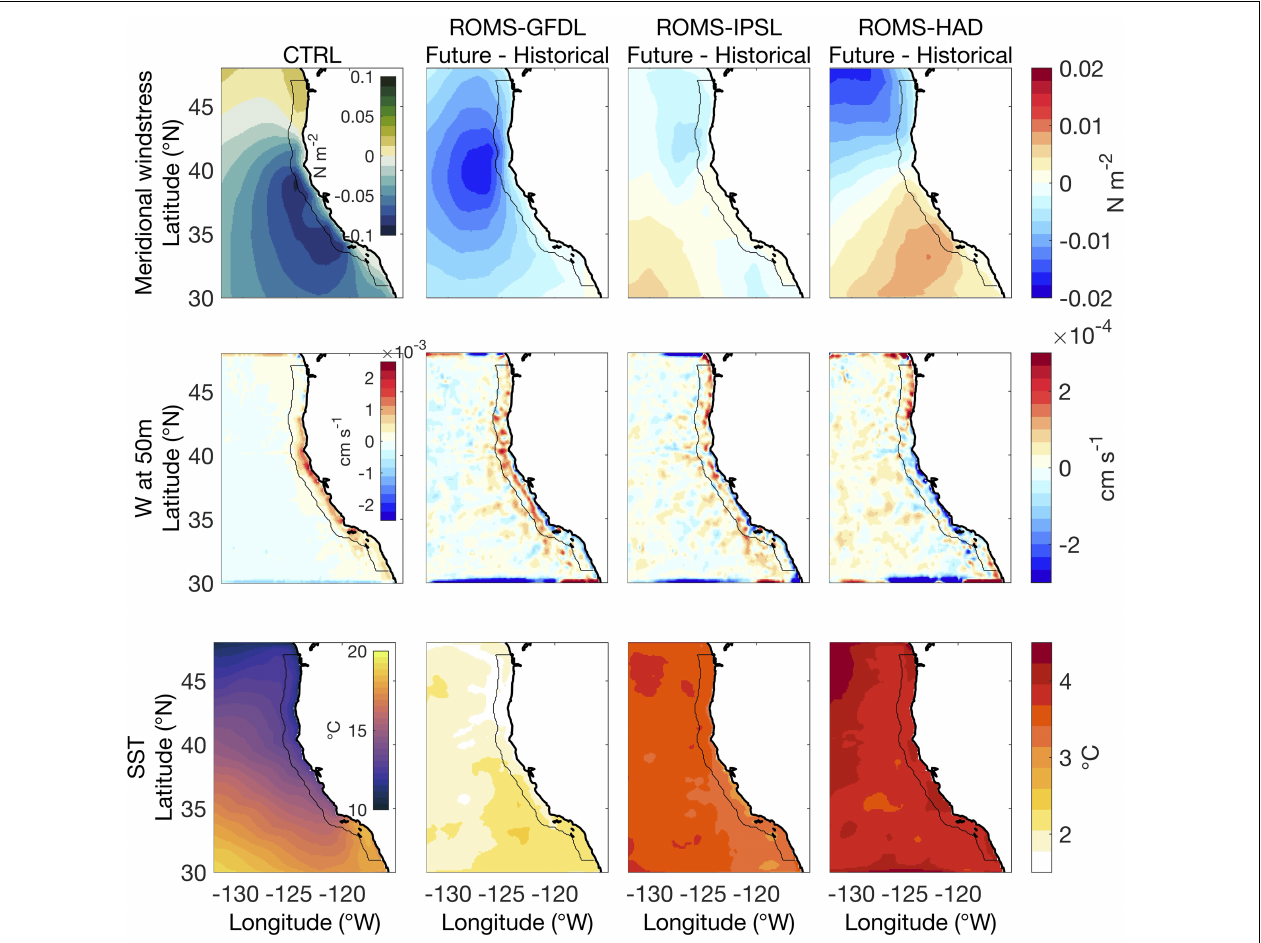
FIGURE 2 | Control run (1980–2010) mean and future changes (2070–2100 relative to historical) for the physical variables. Rows show from top to bottom: meridional wind stress, vertical velocity at 50 m depth (w), and sea surface temperature (SST). Columns show data for the historical period in the control simulation (CTRL, first column) and the future changes from the high-resolution downscaled projections: ROMS-GFDL (second column), ROMS-IPSL (third column), and ROMS-HAD (fourth column). Negative values of wind stress changes correspond to an increase in equatorward wind stress. Black contour marks 100 km from shore. Vertical velocity field has been spatially smoothed out for better